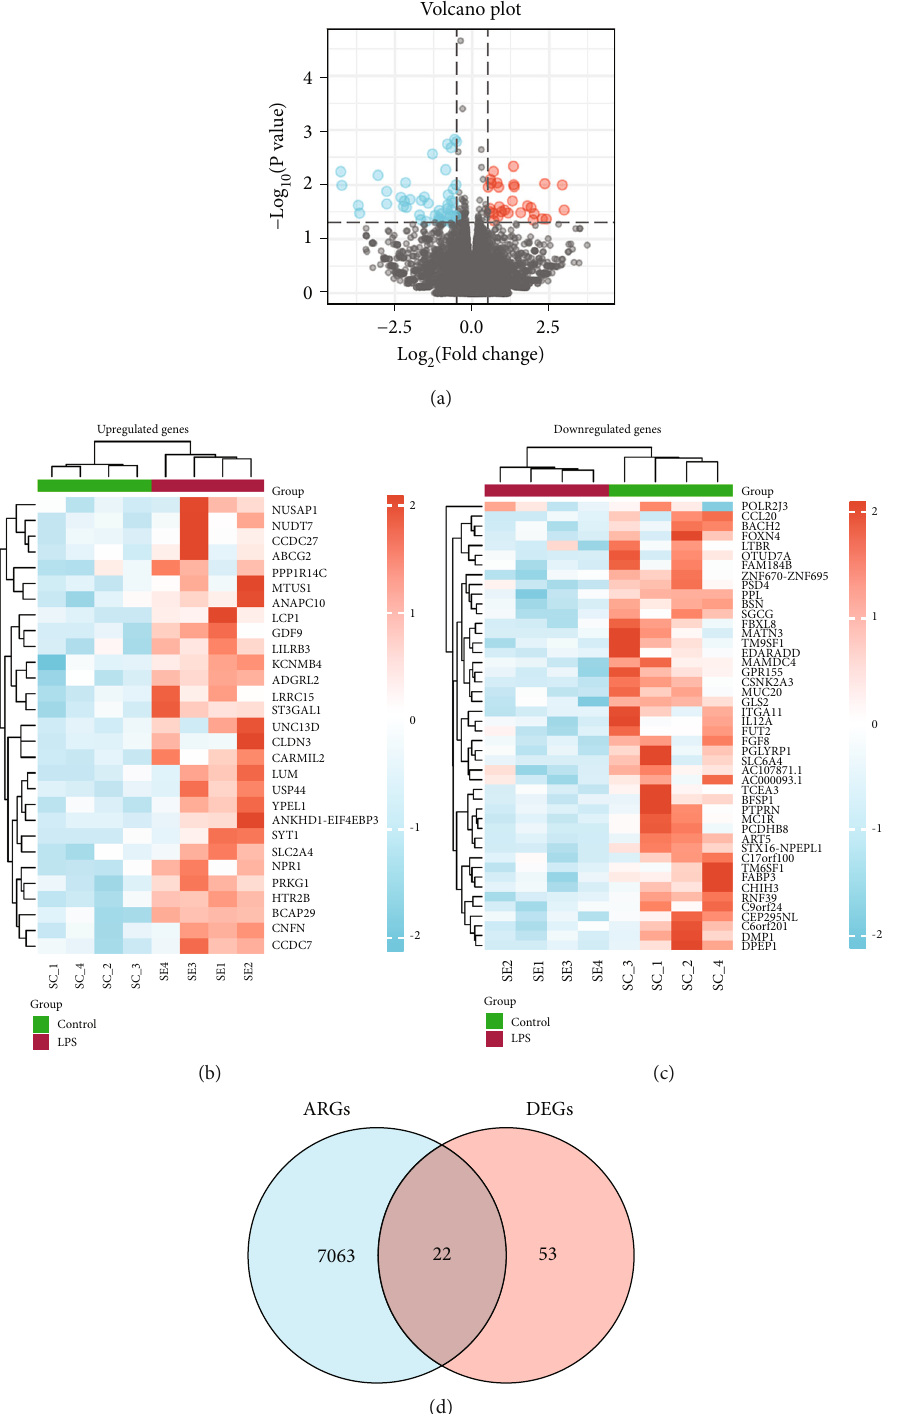
Figure 2: Identi fi cation of di ff erentially expressed genes. (a) The di ff erentially expressed genes. (b) Venn diagram of ARGs and DEGs. (c) The upregulated DEGs. (d) The downregulated